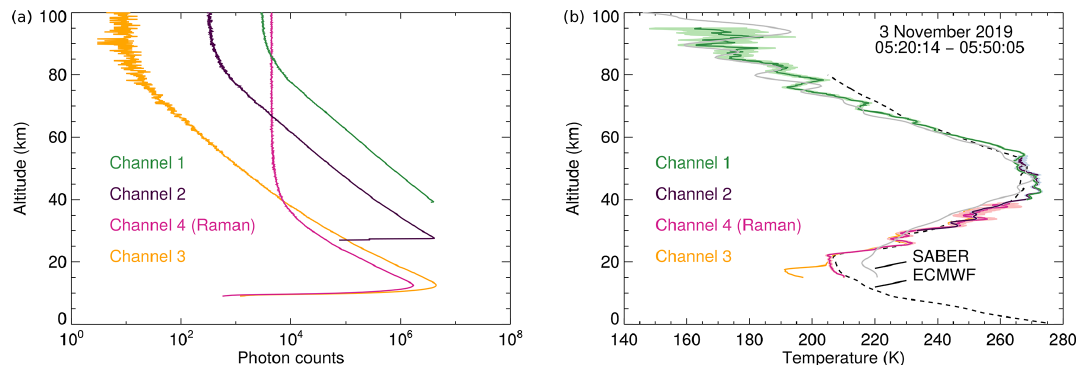
Figure 8. (a) Photon count profiles acquired on 3 November 2019 between 05:20 and 05:50UTC and binned to 100m vertical resolution, and (b) retrieved temperature profiles at 900m vertical resolution. The shaded areas indicate the temperature uncertainties as determined by the retrieval (see Sect. 4). For comparison, the corresponding SABER profile (acquired at 525km mean distance to the west of CORAL at 05:38UTC) and 06:00UTC ECMWF integrated forecasting system (IFS) profile (0.125 ◦ resolution, grid point 53.75 ◦ S, 67.75 ◦ W, 3.9km distance to CORAL) are also shown as gray lines and black dashed lines,